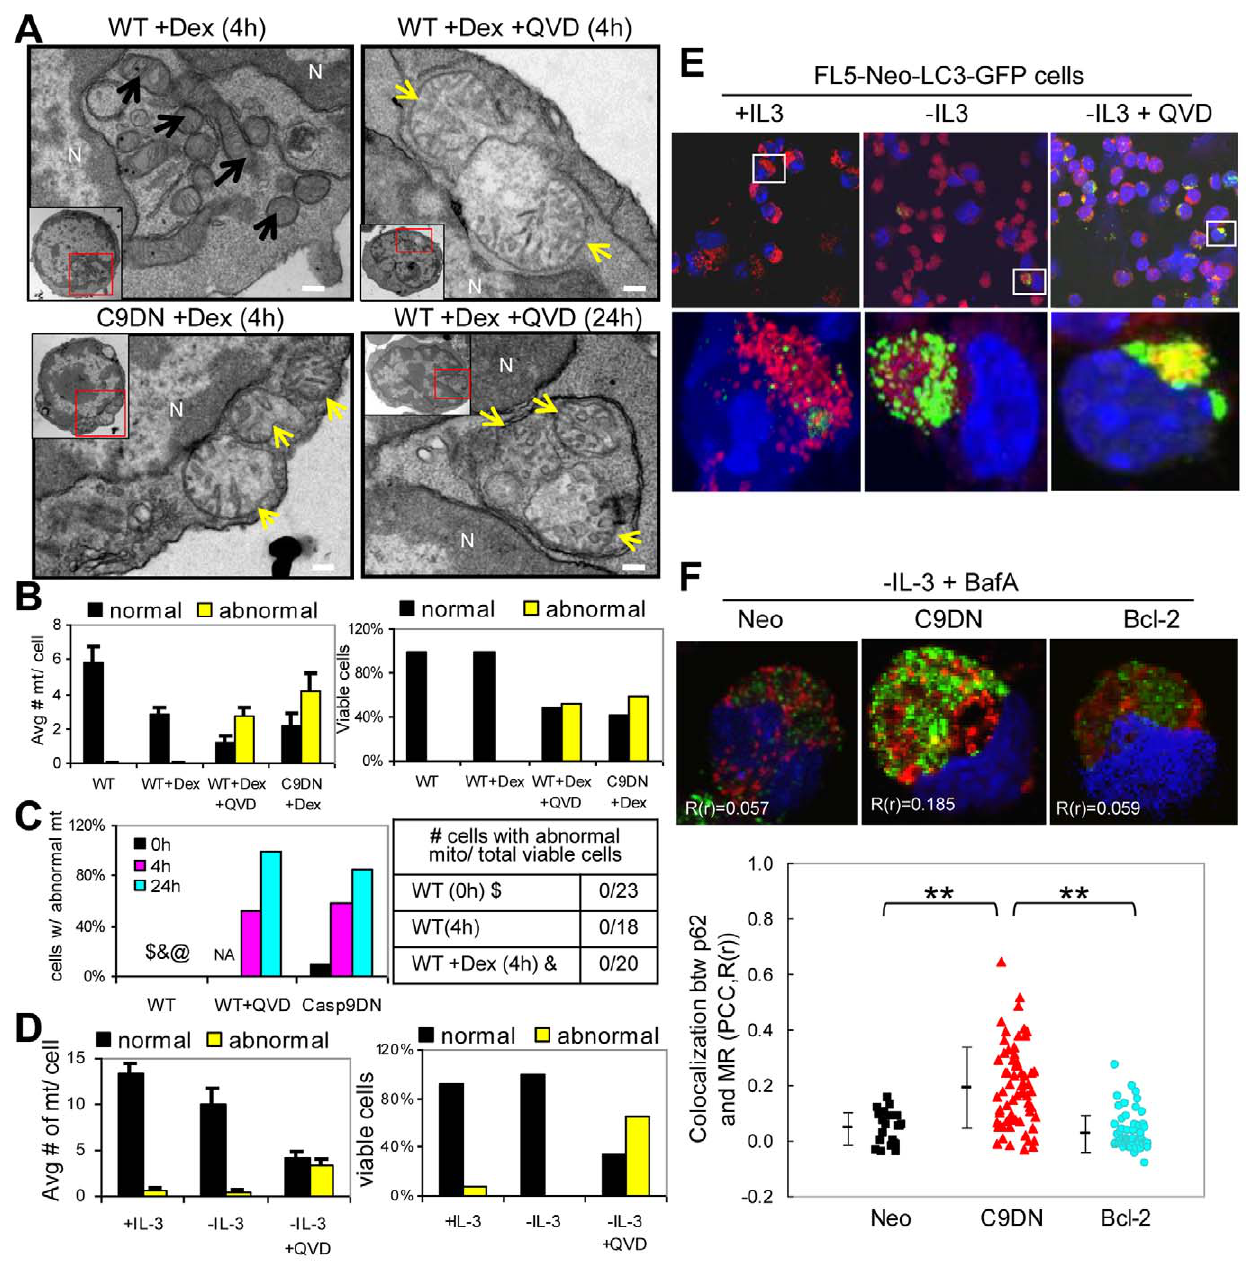
Figure 4. Caspase inhibition increases abnormal mitochondria and activates mitophagy. A ) TEM images showed morphologic changes in mitochondrial structures (normal mitochondria marked with black arrows and abnormal mitochondria marked with yellow arrows) in isolated thymocytes from mice of the indicated genotypes following the indicated treatment. One of examples of mitophagy showed that a mitochondrial cluster was engulfed within double-membrane autophagosome in bottom-right image. Four images have the same magnification. Scale Bar =0.2 m m. N=nucleus. B ) Quantitation of the average number of normal and abnormal mitochondria per viable cell (left panel) and the percentages of cells with at least 1 normal mitochondrion or with at least 1 abnormal mitochondrion (right panel) in isolated thymocytes from mice of indicated genotypes following 4 h of the indicated treatment. C ) Quantitation of the percentage of cells with at least 1 abnormal mitochondria in isolated thymocytes from mice of the indicated genotypes following various times of Dex treatment. Table shows that no abnormal mitochondria were observed in WT thymocytes following various treatments. In the WT thymocytes treated with 24 h of Dex, 5% of the cells were viable, so this sample is not shown (@). WT thymocytes treated with 0 h of Q-VD-OPh were not available (NA). D ) In FL5-Neo cells, quantitation of the average number of normal and abnormal mitochondria per viable cell (left panel) and the percentages of viable cells with at least 1 normal mitochondrion or with at least 1 abnormal mitochondrion (right panel) following 24 h of the indicated treatments. E ) FL5-Neo cells transfected with LC3-GFP (green) were stained with MitoTracker Red (red, MR) for mitochondria and TO-PRO-3 probe (blue) for nuclear counter staining following 48 h of the indicated treatment. The viability of FL5 cells: 97% ( + IL-3), 9% (-IL-3), and 66% (-IL-3 + QVD). Colocalization of MR and LC3-GFP indicated mitophagy activation. F ) FL5 cells with the indicated expression were immuno-stained with p62 (green), MR (red) for mitochondria and TO-PRO-3 probe (blue) for nuclear counter staining following 48 h of IL-3 deprivation and BafA (20 nM). Pearson’s correlation coefficient (PCC, R(r)) which statistically measures colocalization of p62 and MR is shown in each image. Quantitation of PCC of the treated FL5 cells is shown. Each symbol corresponds to PCC of each viable cell of the indicated cell lines. The mean 6 SD of at least 22 cells per cell line in each treatment is shown. ** p , 0.0001.